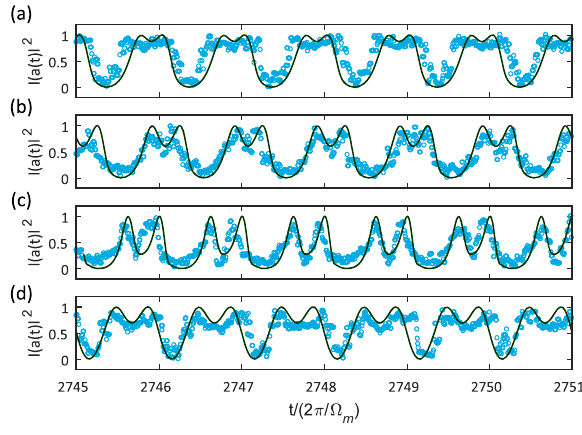
Figure 7: Comparison of the experimental (blue dots) and theoretical (solid line) temporal optomechanical (OM)-generated optical frequency comb (OFC) traces under different experimental conditions. (a) λ L (cid:1) 1543 . 35 nm (experiment) and Δ (cid:1) 4 Ω m (simulation); (b) λ L (cid:1) 1544 . 05 nm (experiment) and Δ (cid:1) 3 . 4 Ω m (simulation); (c) λ L (cid:1) 1545 . 37 nm (experiment) and Δ (cid:1) 2 . 4 Ω m (simulation); (d) λ L (cid:1) 1545 . 62 nm (experiment) and Δ (cid:1) Ω m